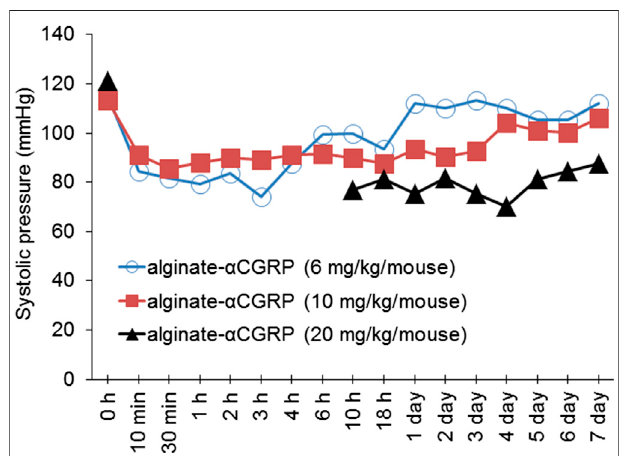
FIGURE2| Effectofalginate- α -CGRPmicrocapsulesonbloodpressure in wild-type mice. Graph showing the systolic pressure, as measured by tail- cuff blood pressure method, after subcutaneous injection of various concentrations of alginate- α -CGRP microcapsules in mice.